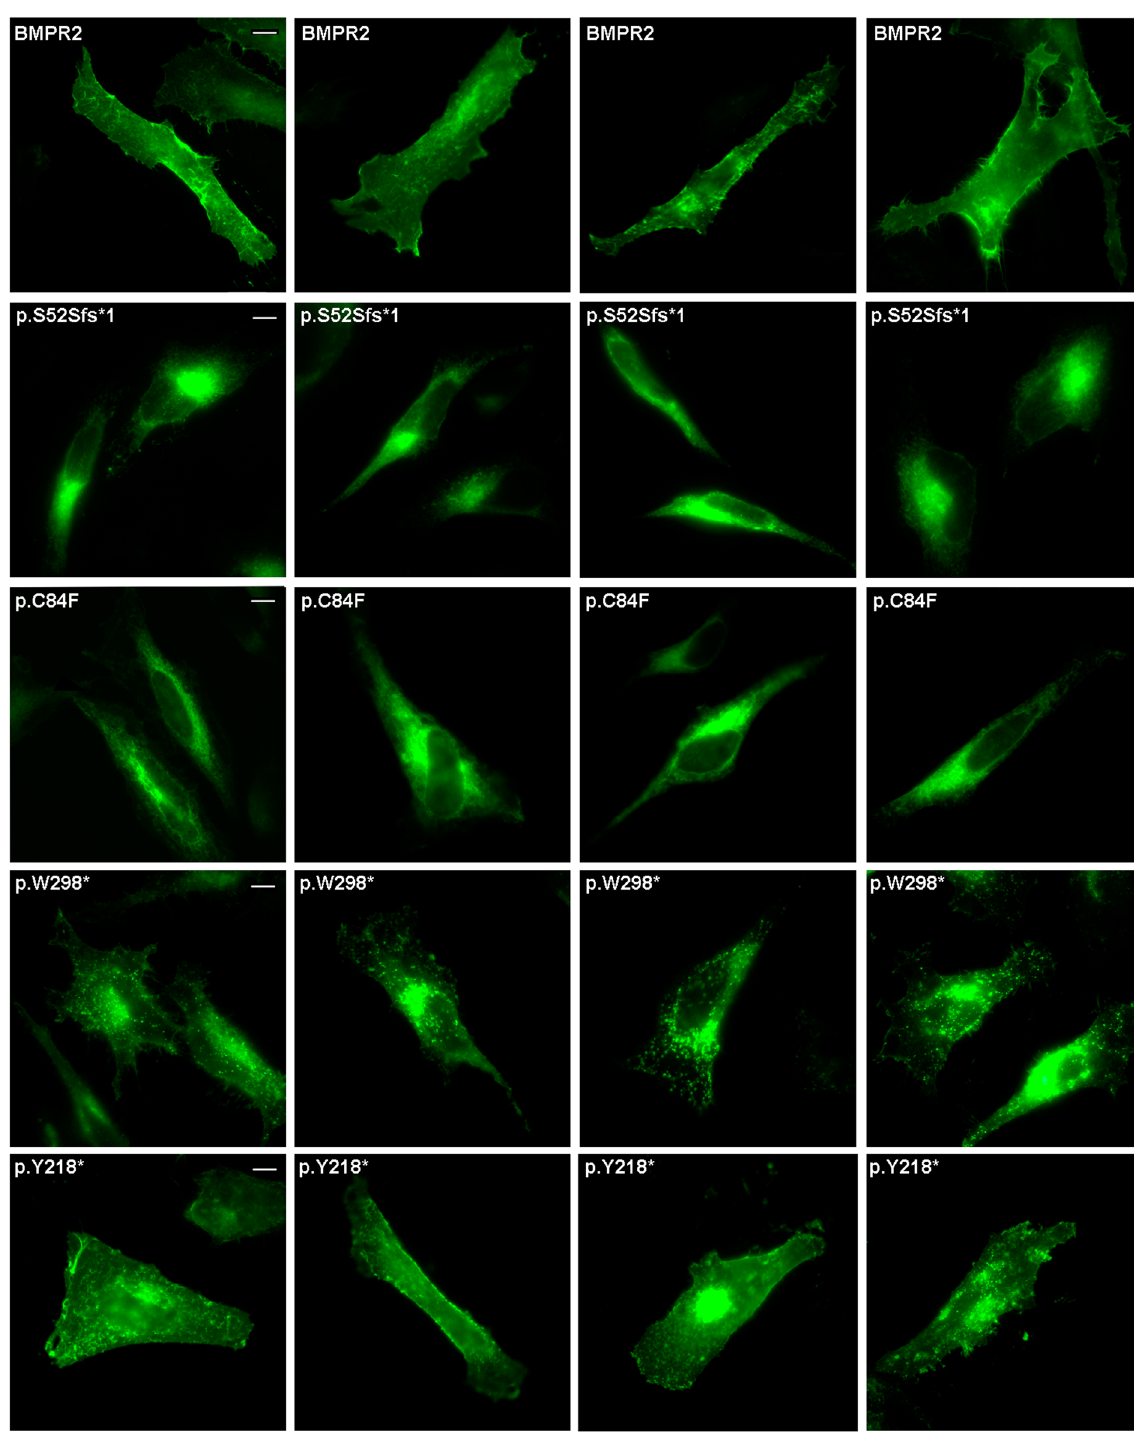
Figure 6. Photomicrograph example of the subcellular localization, in HELA cells, of the BMPR2 wild-type and those mutants which pattern of expression is altered. All these constructs are GFP-tagged at the C-terminus. After 24 h post-transfection, HELA cells were fixed and mounted in Fluoromount-F. Images were visualized using a Leica TCS SP2 confocal system. The scale bar is 10 μ